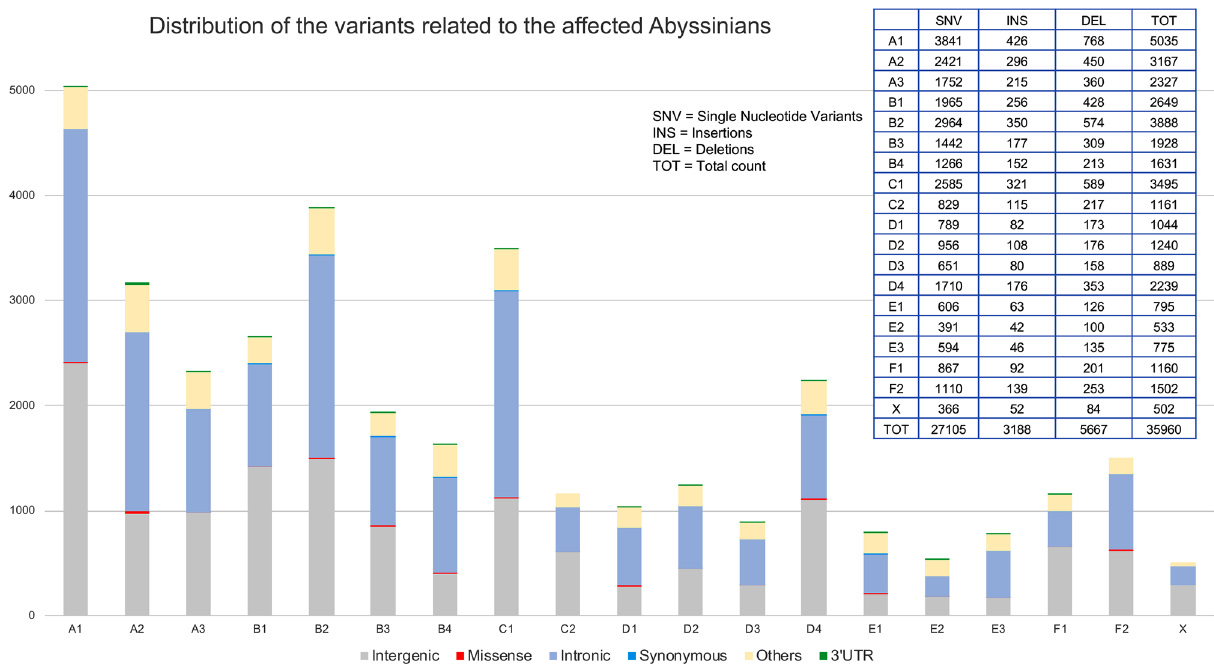
Figure 1. Overview of the different types of variants identified by Whole Genome Sequencing in the two affected Abyssinian cats compared to the Control Population with the Golden helix SVS Software. Variants distribution is reported for each cat chromosome. Variants referred to the class of “Other” included 5 ′ UTR variants, downstream and upstream gene variants, non-coding transcript exon variants, and splice region